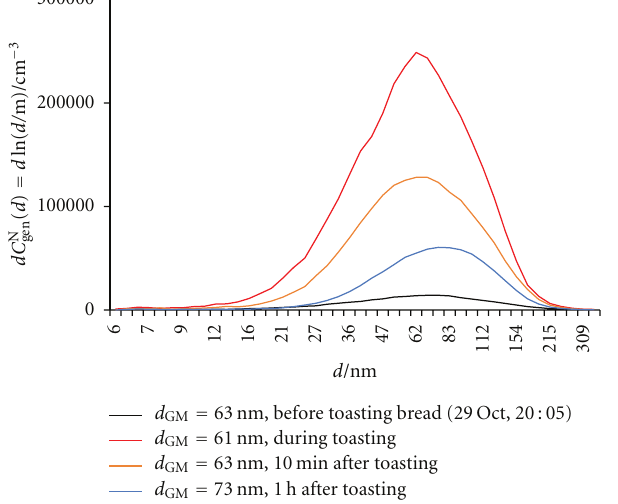
Figure 16: Number size distributions (d C N